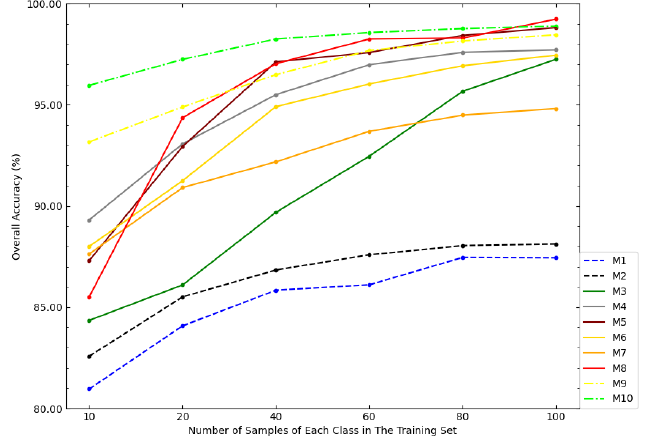
Figure 8. The OAs of each model in the Salinas dataset under the partitioning of training sets of different sizes.